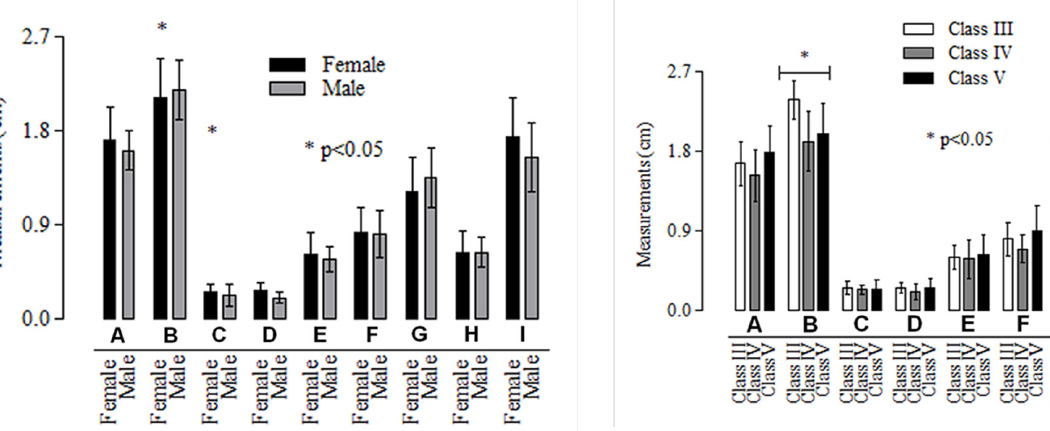
Fig. 4. Association between the types of edentulous jaws (III, IV, V) and the measurements of the mandible width (A) and height (B), mandibular canal width (C) and height (D), distance of the mandibular canal to buccal (E), lingual (F), superior (G) and inferior (H) corticals of the mandible and the distance of the mandibular canal to the higher point of the alveolar ridge